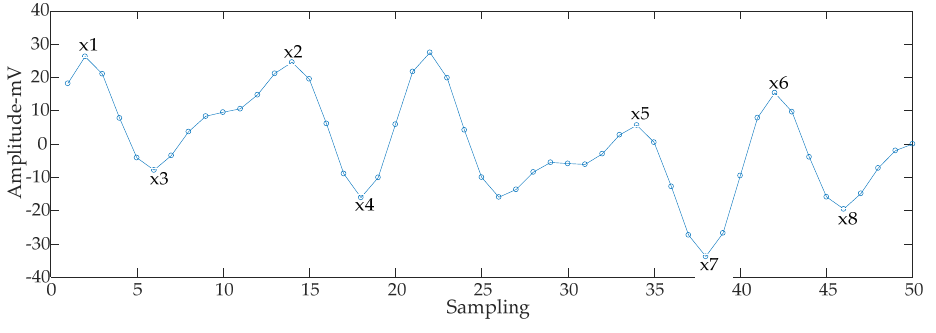
Figure 9. Mean continuation diagram.